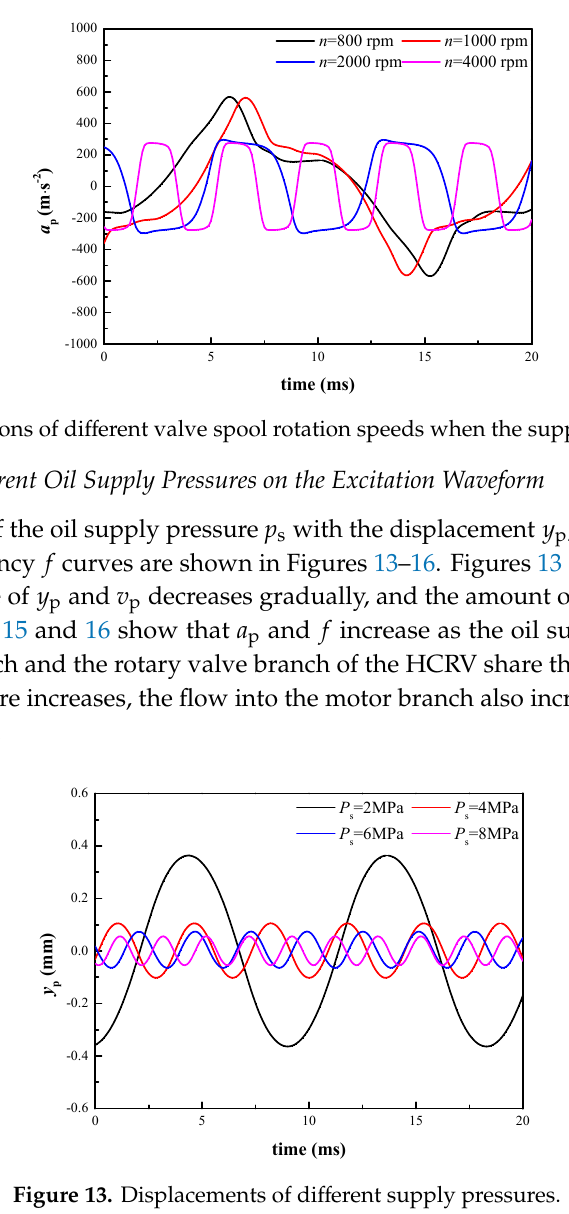
Figure 11. Velocities of different valve spool rotation speeds when the supply pressure is 4 MPa.